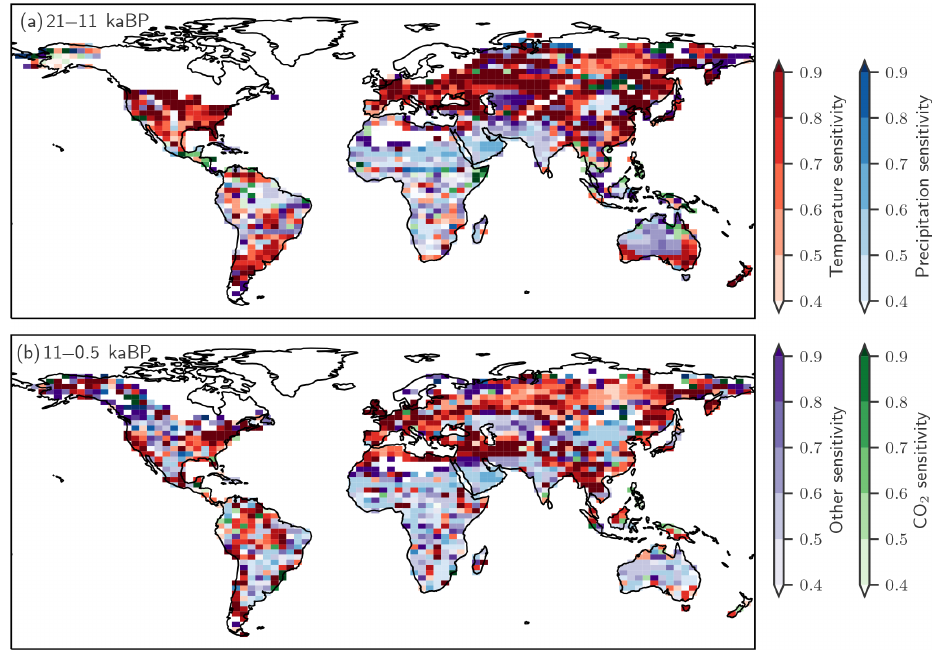
Figure 10. The dominant drivers for changes in terrestrial N 2 O emissions over (a) the glacial termination and (b) the Holocene are temper- ature (red), precipitation (blue), CO 2 (green), and other non-linear effects in LPX-Bern(v1.4N) on these driver combinations (violet). The colour shading indicates the fraction of the total emission change attributed to the dominant driver typically explaining between 40% and 90%. Areas with minimal changes are